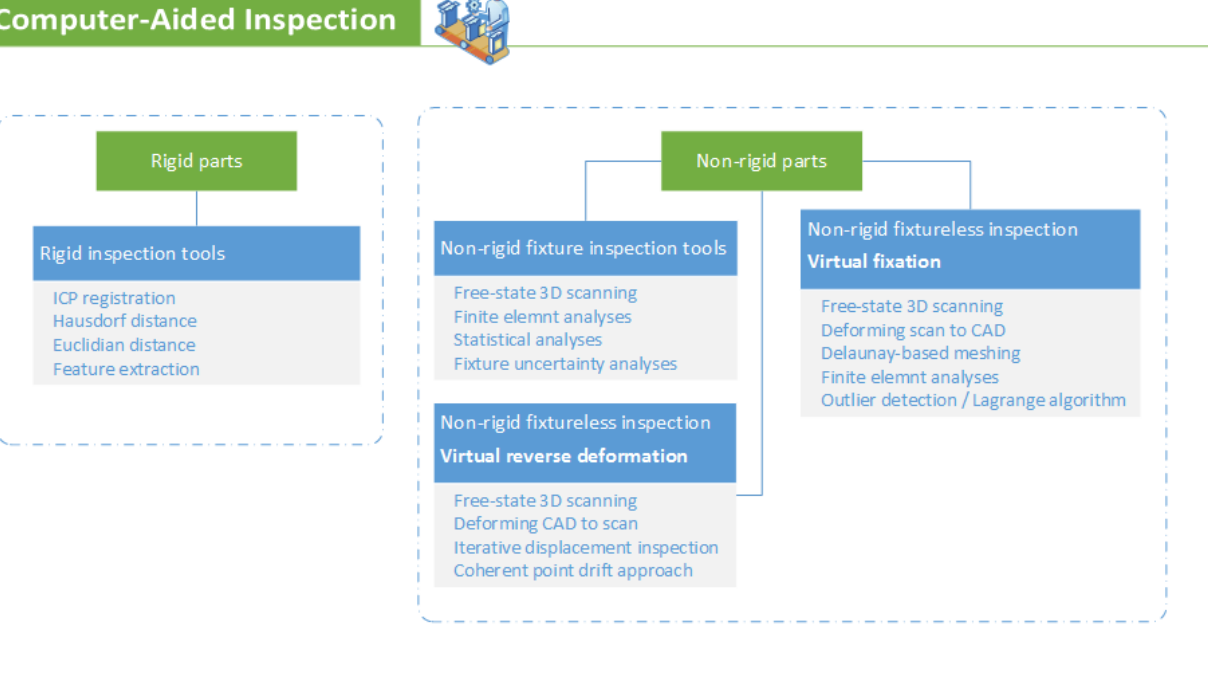
Figure 1. Computer-Aided Inspection methods and tools [33].